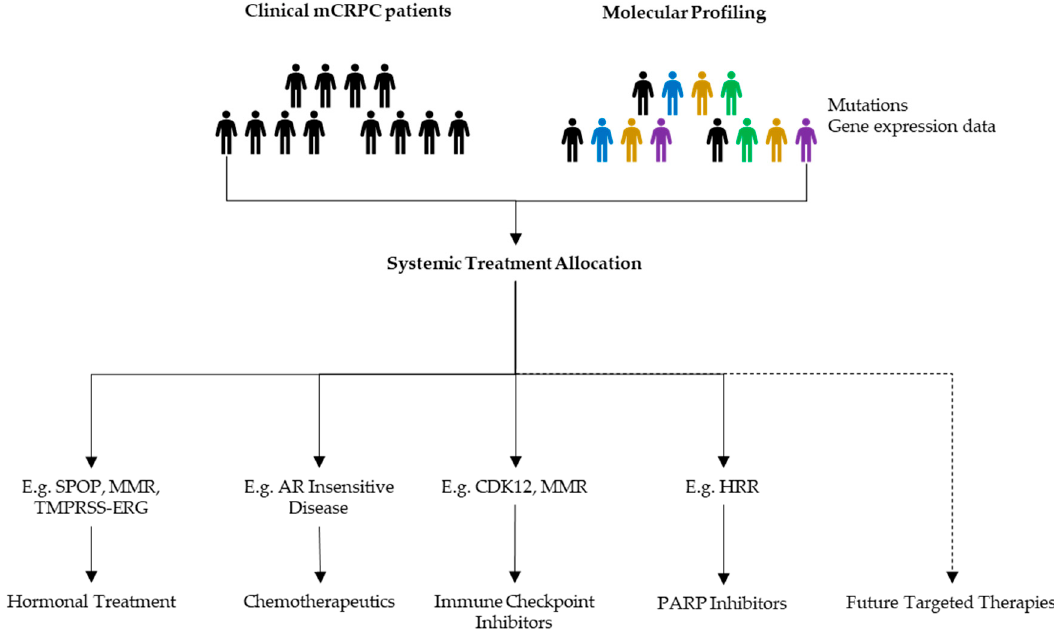
Figure 3. Possible benefits of molecular profiling in mCRPC management. When progressive disease appears, discussions upon next line treatments should be based upon all available data to allocate a patient tailored follow-up treatment.